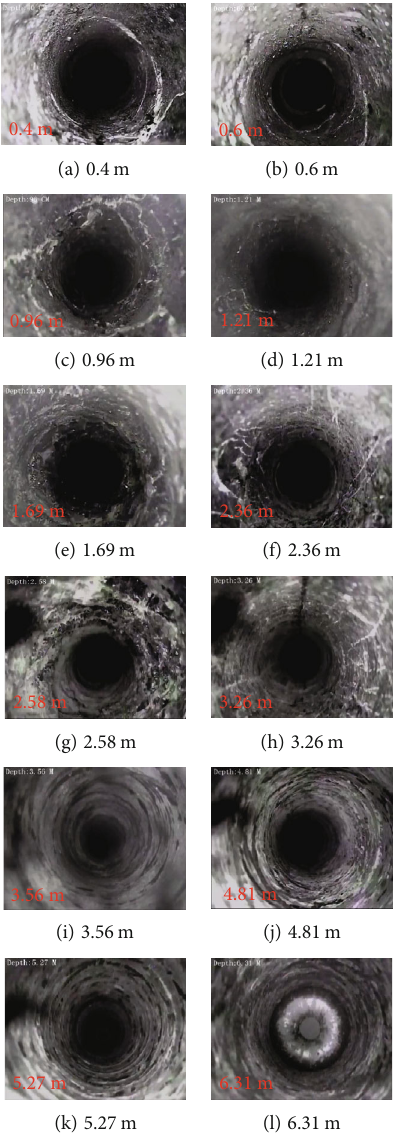
Figure 13: Results of the borehole